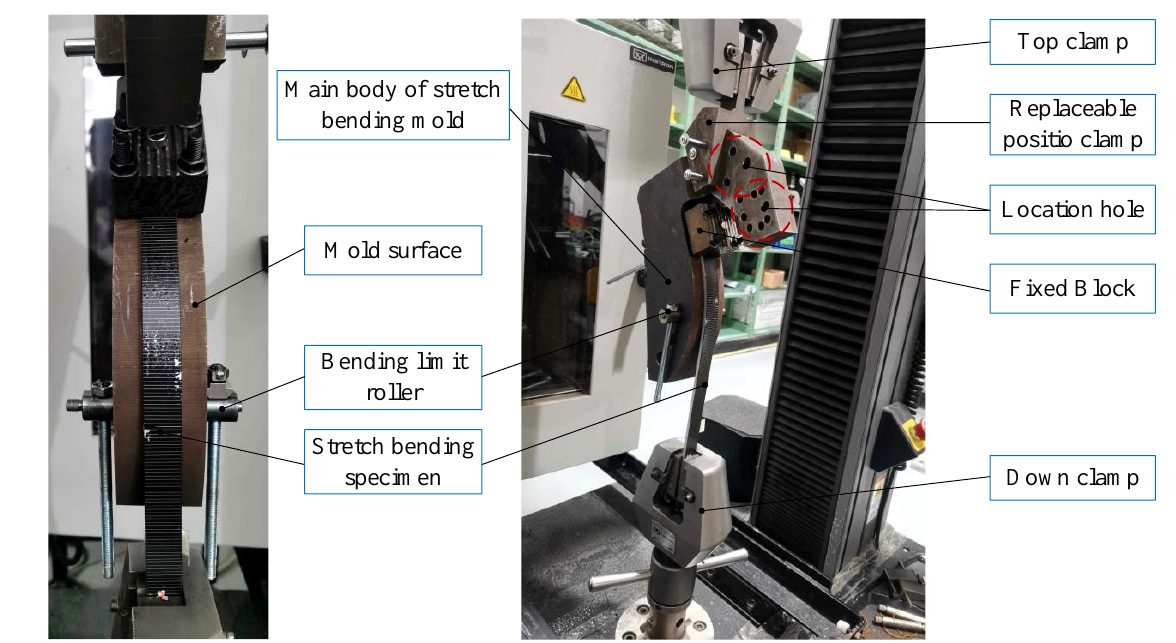
Figure 9. Equivalent stretch-bend experiment. Table 5. The equivalent of the stretch-bend experiment parameters.